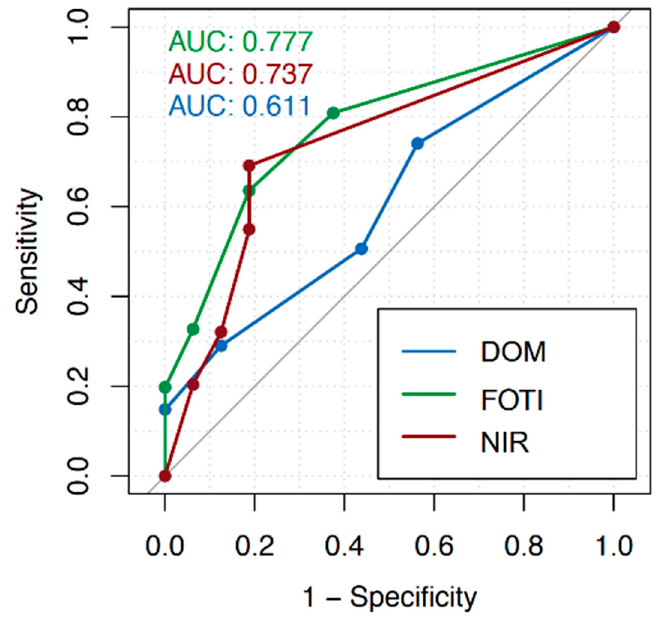
Figure 3. Receiver operating characteristic (ROC) curves considering vestibular/oral surfaces only (dental operating microscope, DOM; fiber-optic transillumination, FOTI; near-infrared transillumination, FOTI) and different cutoff values of the crack depth scores. The diagnostic value of each method was calculated as the area under the curve (AUC).